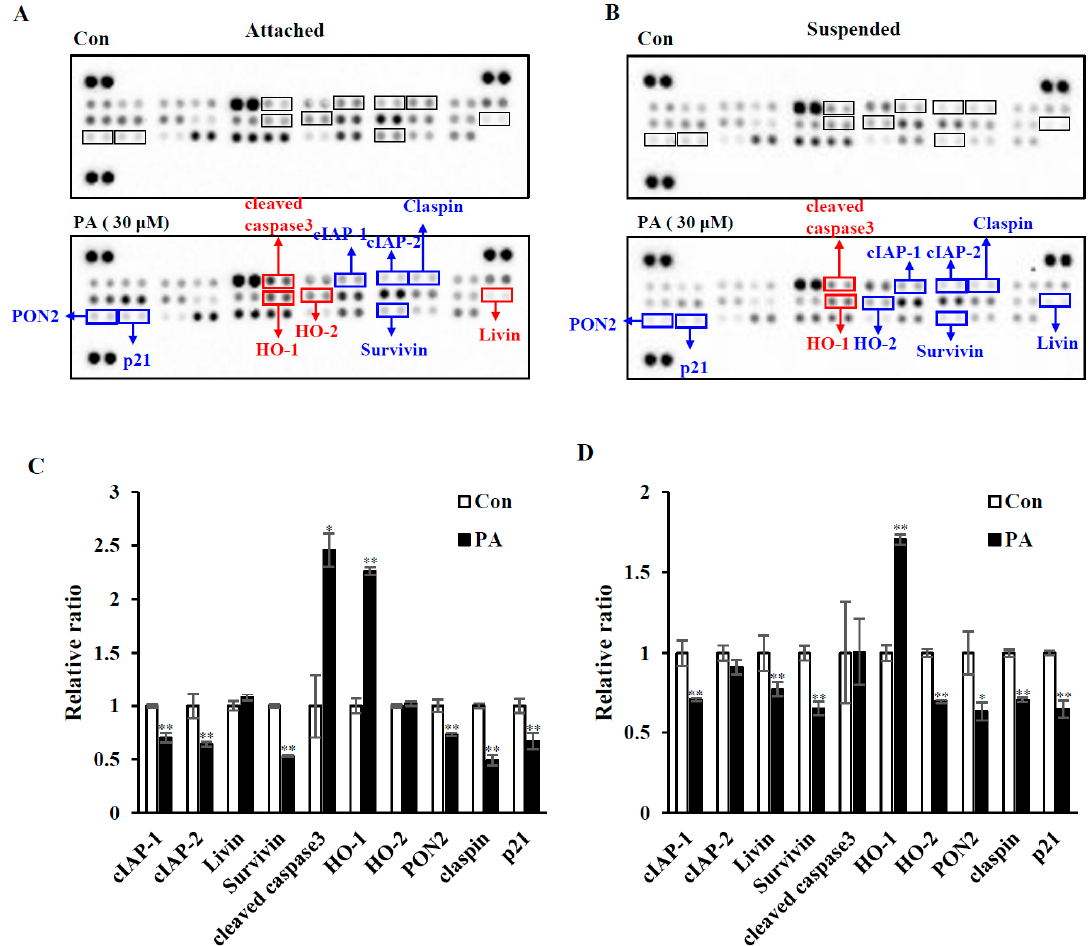
Figure 2. Analysis of apoptosis protein array of PA-treated MDA-MB-231 cells ( A – D ) MDA-MB-231 cells in attached ( A ) or in suspended culture ( B ) were treated without (control) or with 30 µ M PA, and then equal amounts of cellular proteins were subjected to a protein array using the Proteome Profiler Human Apoptosis Array Kit (R&D system), as described in Section 4. Representative scanned images are shown ( A , B ). Scanned images of A and B were quantified with a densitometer and expressions relative to the control are shown in ( C , D ), respectively. Similar results were observed in three independent experiments. Error bars represent standard deviations of the means of three measurements (* p < 0.05, ** p < 0.01).